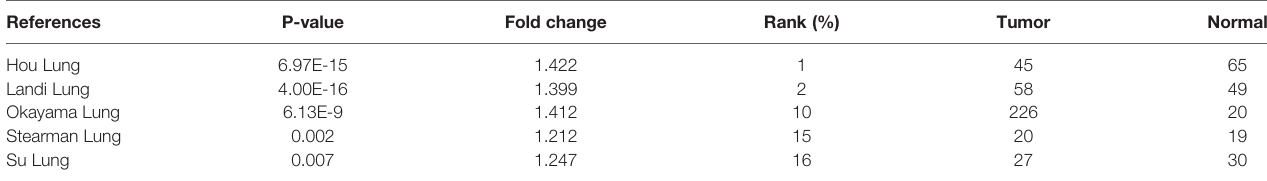
TABLE 1 | The signi fi cant changes of heterogeneous nuclear ribonucleoprotein C (HNRNPC) expression in transcription level between lung adenocarcinoma and normal